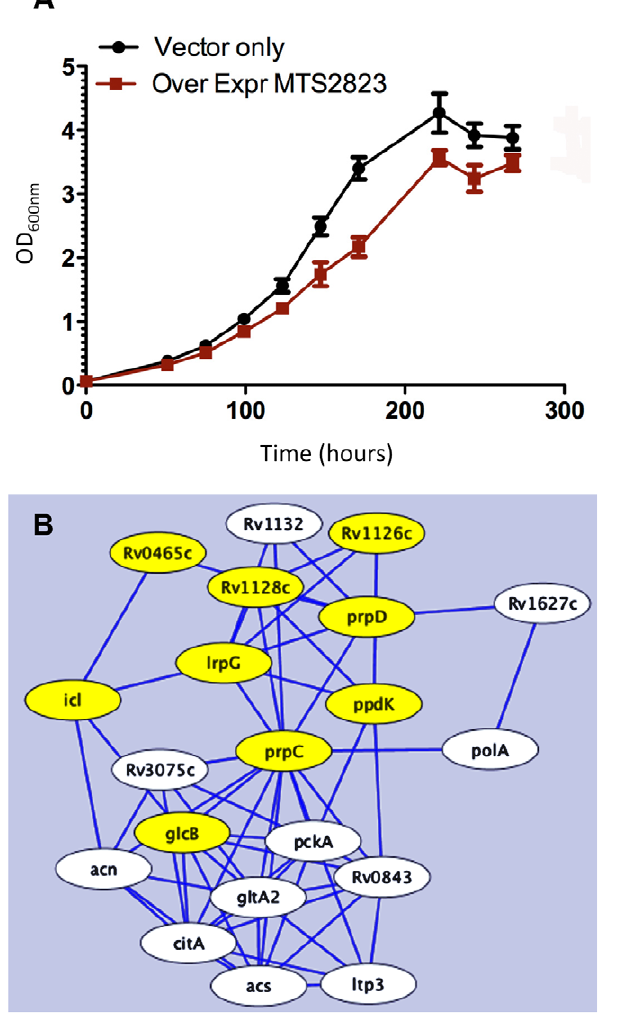
Figure 9. Accumulation of sRNAs during infection. Quantitative RT-PCR confirmed the findings from sequence analysis and Northern blotting that the abundance of MTS0997, MTS1338 and MTS2823 is markedly increased in stationary phase cultures in contrast to the reduction in groES mRNA. Analysis of M. tuberculosis RNA from the lungs of chronically infected mice showed a further increase in the amount of each of the sRNAs relative to 16S rRNA control.